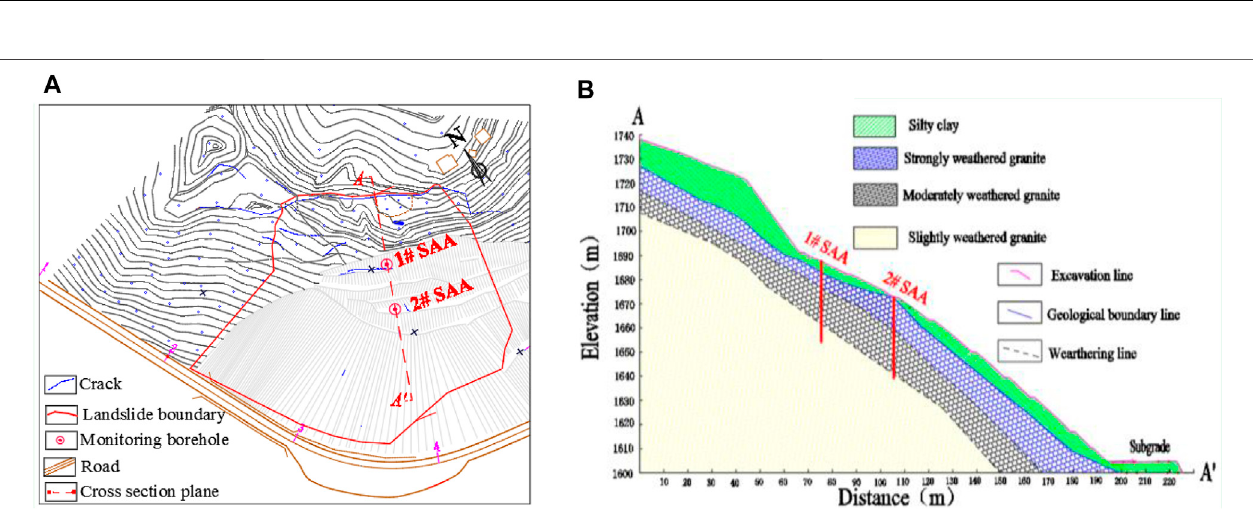
FIGURE 8 | (A) Topographic map of the Jinping County North Landslide, the grey lines denote excavation. (B) A-A ′ cross-section.